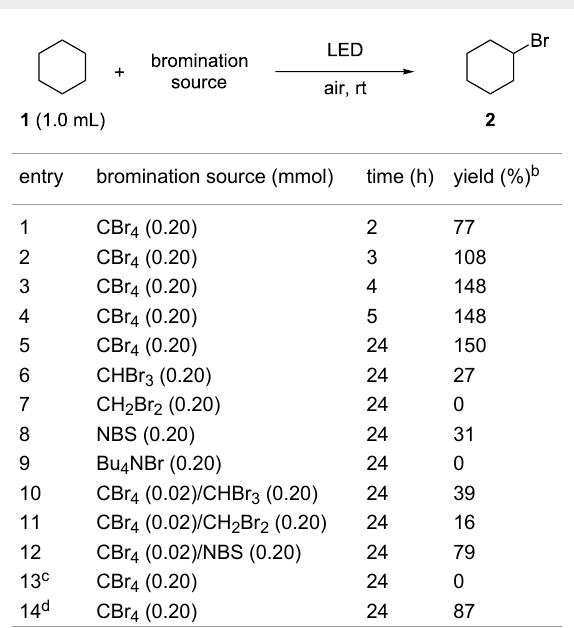
Table 1: Bromination of cyclohexane using CBr 4 under LED irradi- ation. a